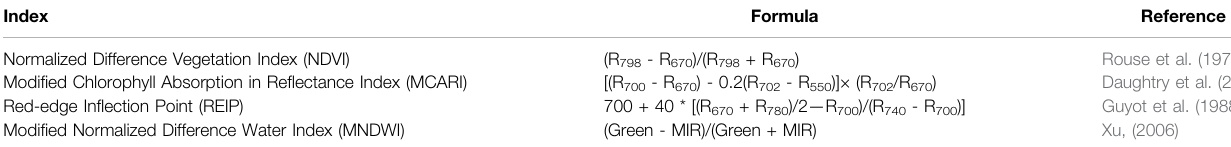
TABLE 3 | Vegetation and water indices used in mapping the mangrove zonation using